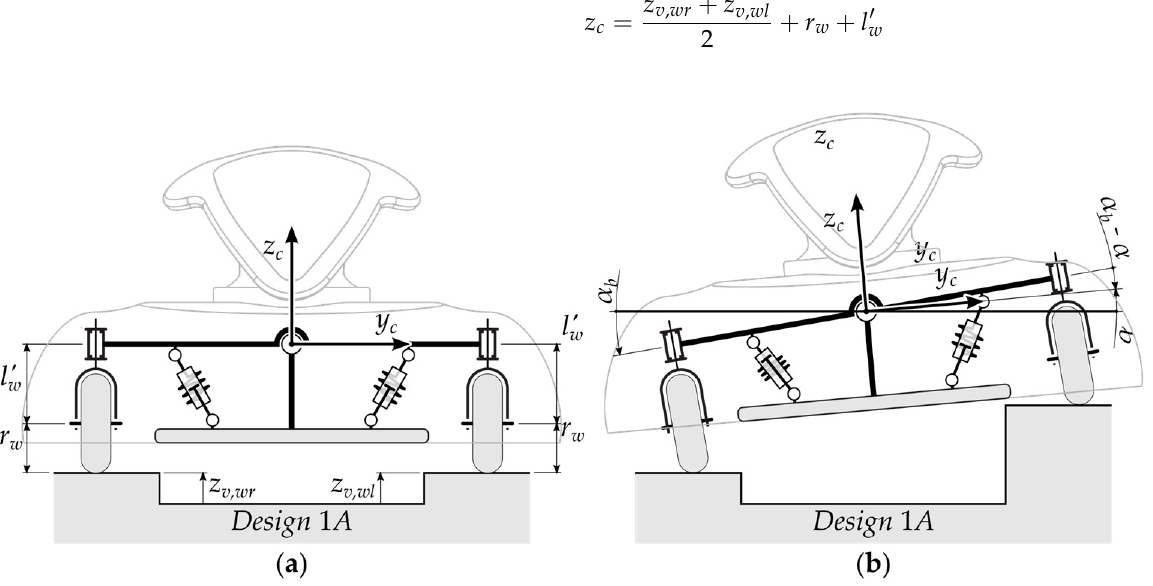
Figure 6. One arm suspension configuration: ( a ) Relevant geometrical parameters; ( b ) Definition of angular coordinates. The spring-damper devices represented in Figure 6b can be modelled using an equiv- alent torsional spring-damper system characterized by the torsional stiffness k roll and the torsional damping coefficient c roll . This equivalent system works on the relative